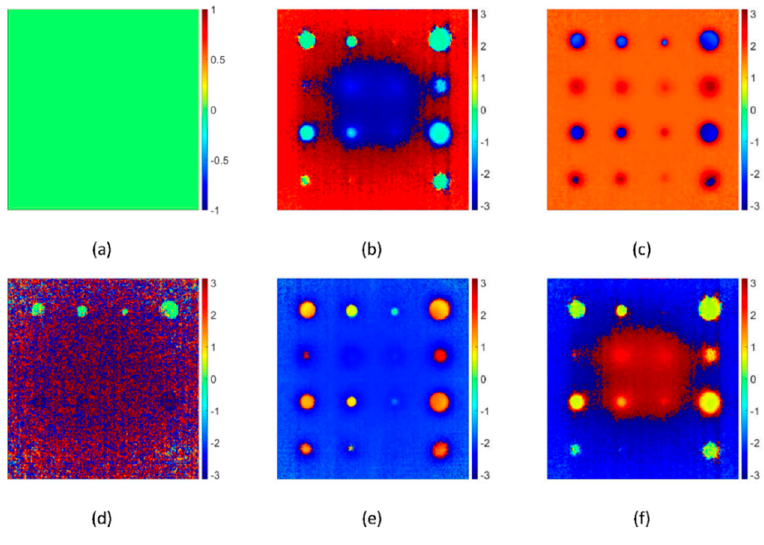
Figure 9. Phase images obtained with pulsed phase thermography for a steel plate with flat bottomed holes after pulse heating at different frequency spectra, ( a ) 0.2 Hz, ( b ) 0.4 Hz, ( c ) 8 Hz, ( d ) 25 Hz ( e ) 42.6 Hz and ( f ) 50 Hz, number of frames = 250 frames, truncation window 5 s. Phase angle scales are in radian.